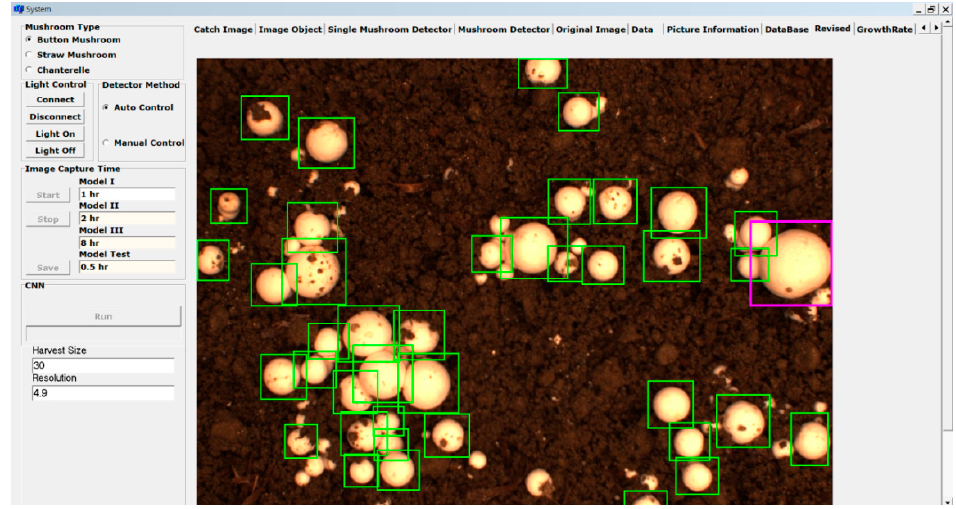
Figure 7. The human machine interface of the mushroom measurement system.